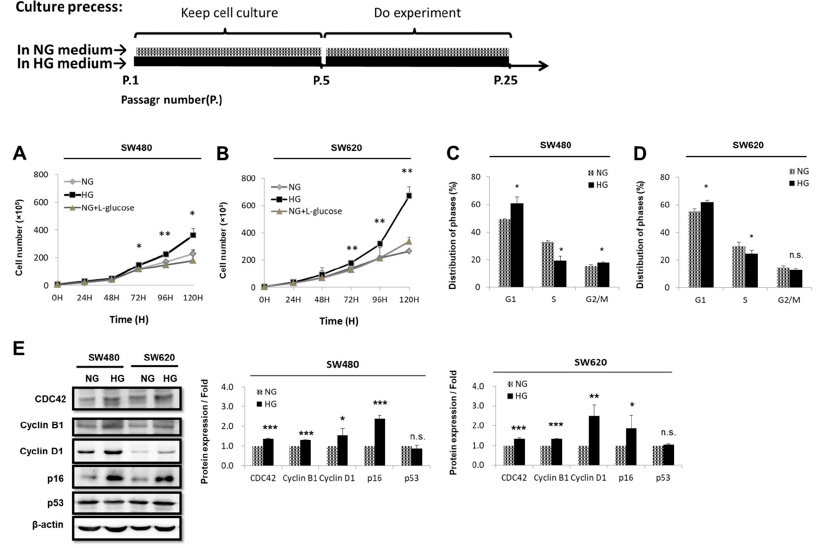
Figure 1. Glucose promoted cell proliferation and induced cell-cycle-regulated protein expression in colorectal cancer (CRC) cells. ( A ) SW480 (low metastatic potential) and ( B ) SW620 (high metastatic potential) cells were cultured in medium with different concentrations of glucose: Normal glucose